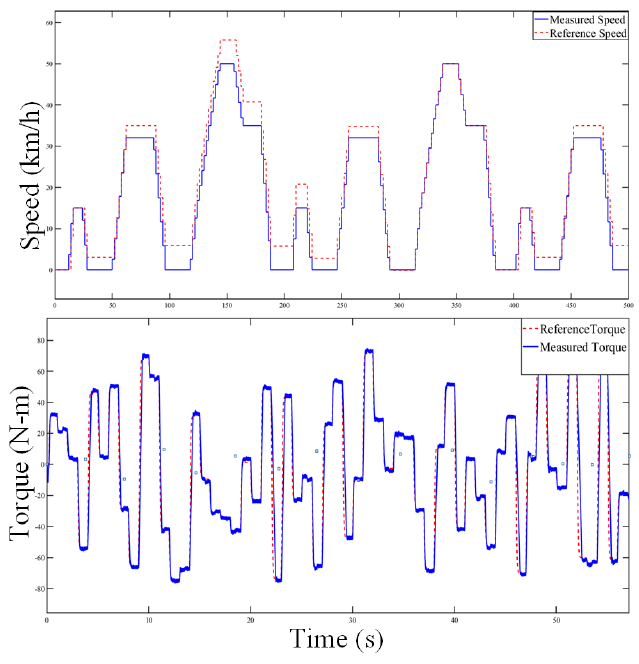
Figure 18. Driving cycle response for vehicular application.